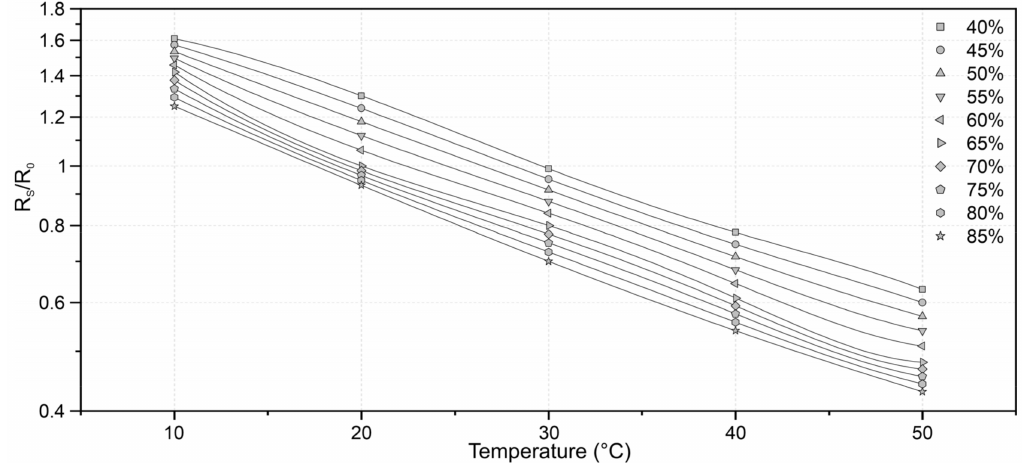
Figure 5. Dependence curves of R s /R 0 in relation to the temperature and relative humidity of the air used for signal